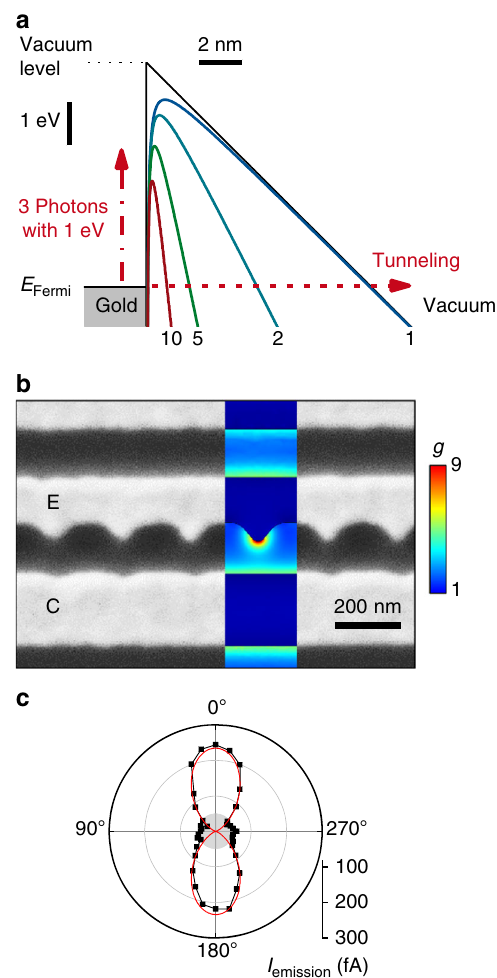
Fig. 2 Asymmetric nanoscale junctions for plasmonically enhanced photoemission. a Schematic energy diagram of the gold-vacuum interface at the emitter with present electric fi eld F pump = 0.5 V nm − 1 (black line). The Fermi energy E Fermi is ~5.1 eV below the vacuum level (dotted line). The barrier can be overcome by a multiphoton absorption (vertical dashed dotted line) or a tunneling process (horizontal dashed line). The colored lines consider the Schottky effect and a fi eld-enhancement of 1 (blue), 2 (turquoise), 5 (green), and 10 (red). b SEM image of asymmetric nanojunctions with emitter ( ‘ E ’ ) and collector ( ‘ C ’ ) electrodes. Inset: numerically computed fi eld enhancement g within such an asymmetric nanojunction for E pump = 1.3 eV. c Polarization dependence of I emission at E pulse = 150 pJ and a FWHM of 14 fs of the pump pulse. Red line is a cosine fi t, the gray area in the center indicates the noise level obtained